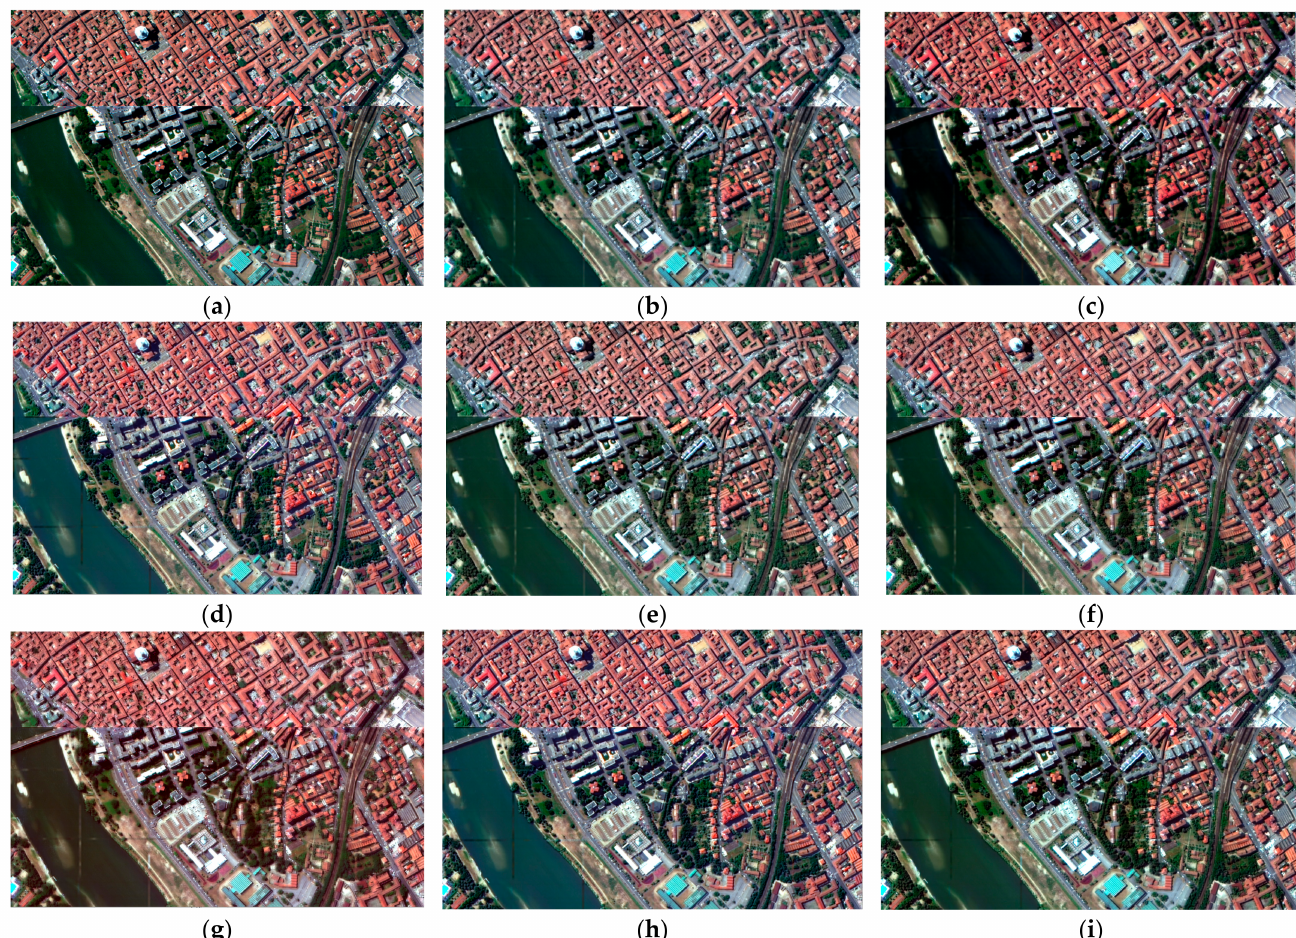
Figure 13. RGB images of ground truth, the different methods and the proposed EDRN method for the Pavia Center dataset: ( a ) Ground truth, ( b ) AWLP, ( c ) CNMF, ( d ) GIHS, ( e ) MTF_GLP, ( f ) HPF, ( g ) SFIM, ( h ) DIP-HyperKite and ( i )